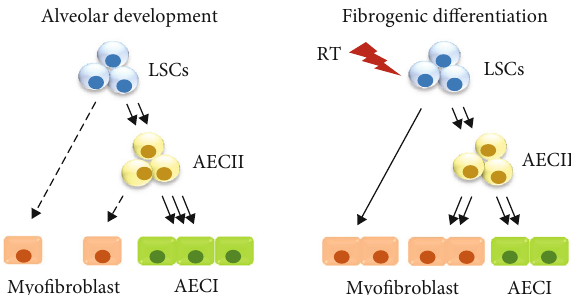
Figure 6: Model of LSC di ff erentiation in alveolar development and irradiated tissue. LSCs (blue): lung stem cells; AECII (yellow): type II alveolar epithelial cells; AECI (green): type I alveolar epithelial cells; RT: